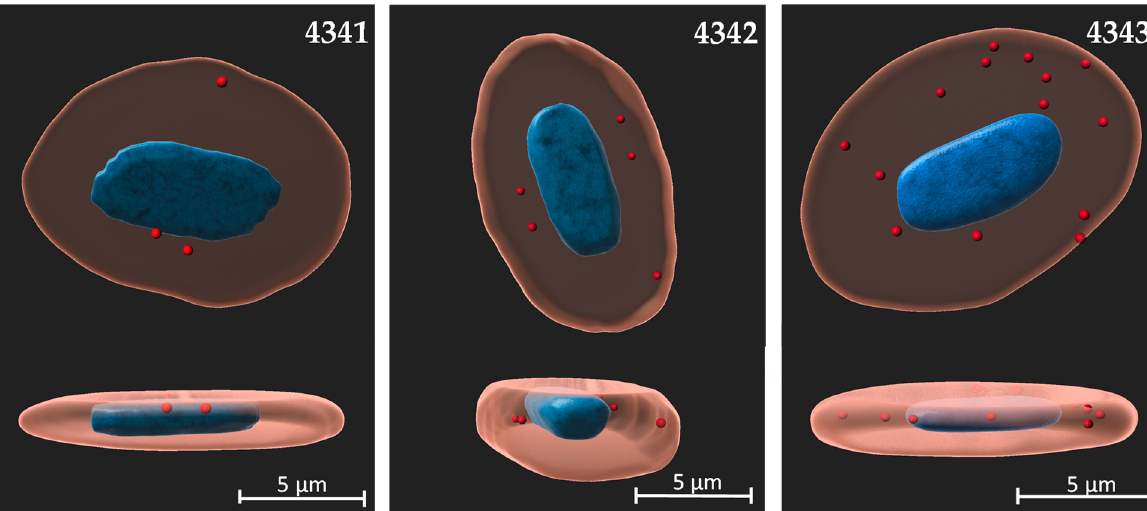
Figure 2. Volume 3D reconstruction of the visualization of the peptides binding to rainbow trout RBCs. Rhd-labeled peptides are represented in red, nuclei were stained with Hoescht and are represented in blue, and cell membrane was stained using CellMask Green and is represented in beige. The images were taken at 63× magnification. Confocal images were processed using the ZEN 3.2 (Blue edition). Volume rendering was performed with IMARIS v9.3. Upper images represent plan view and lower images represent perspective view.